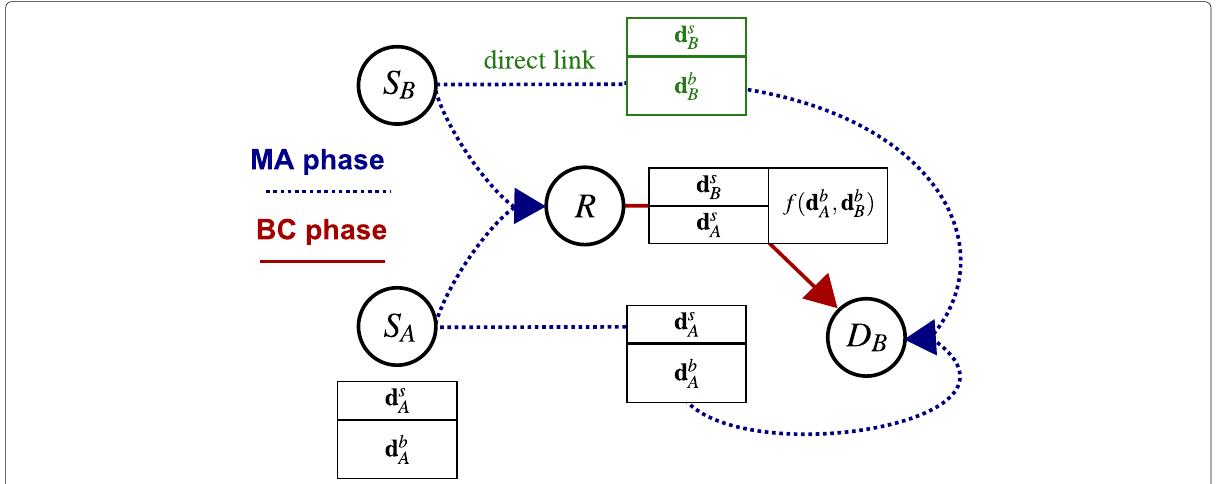
Fig. 16 Direct channel at destination D B in the robustness analysis (likewise, a direct channel is assumed to be present also at D A